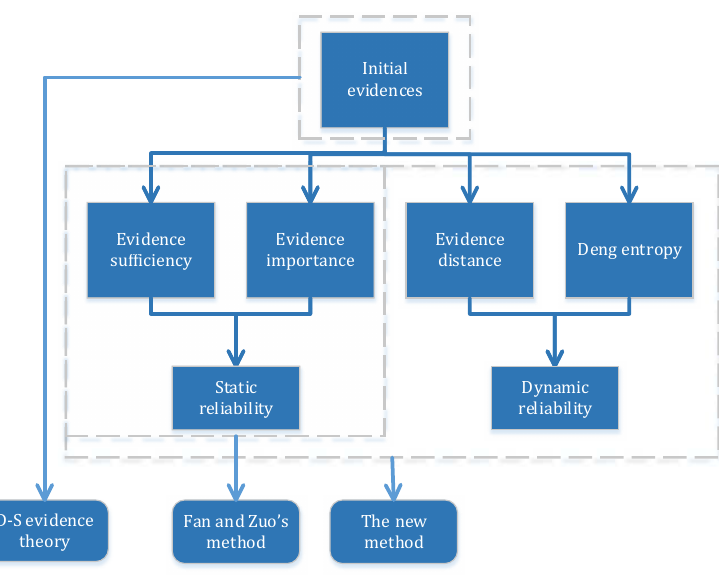
Figure 2. The relationship between Fan and Zuo’s method and the new method.